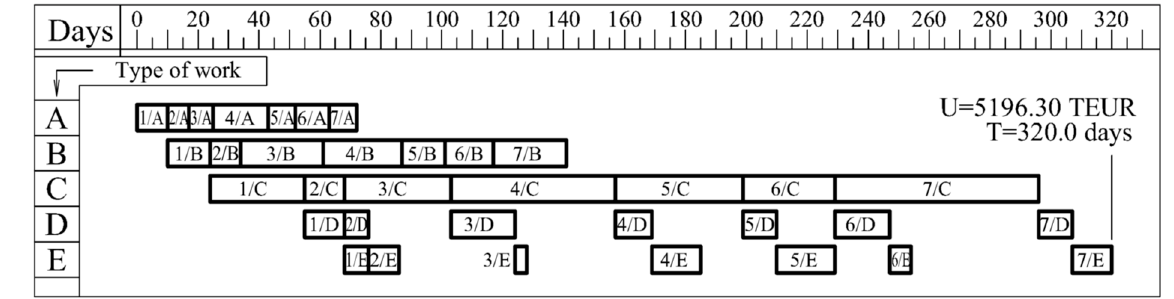
Figure 4. Permutation π 0 —construction project schedule not considering LAF.